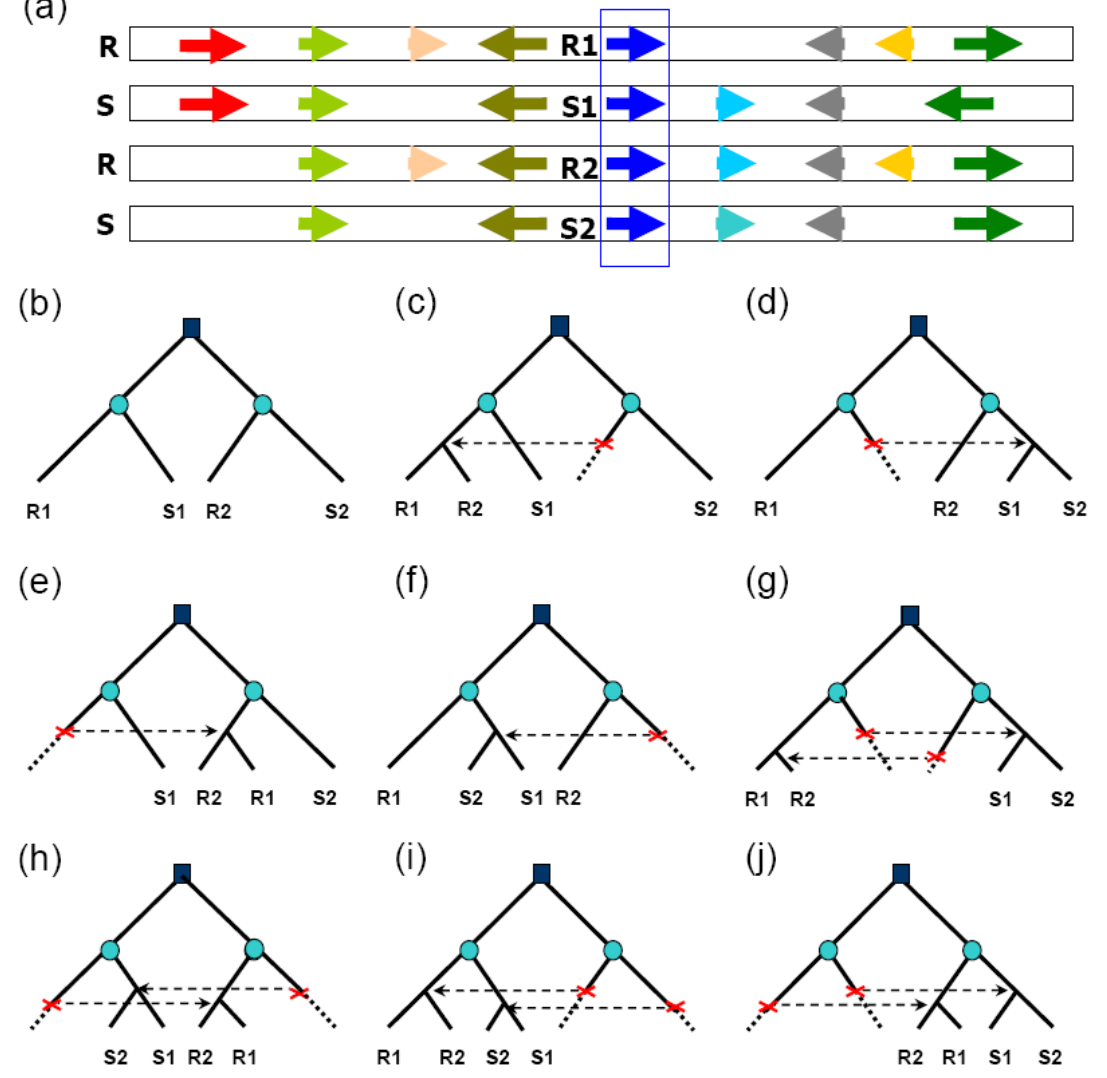
Figure 1. Definition of homologous gene quartets and inference of conversion based on phylogenetic topology changes. In ( a ), arrows show genes with colors reflecting homology. Gene quartets are formed by rice (R) paralogs R1 and R2, and their respective sorghum (S) orthologs S1 and S2. In ( b ) to ( j ), squares symbolize a duplication event in the common ancestral genome, and circles symbolize species divergence. The expected phylogenetic relationship of the homologous quartets is displayed in ( b ) if no conversion has occurred; ( c ) to ( j ) show different types of conversion, for example, ( c ) shows the expected pattern if gene R2 is converted by R1; ( d ) if gene S1 is converted by S2; and ( g ) if both the above conversions occurred.